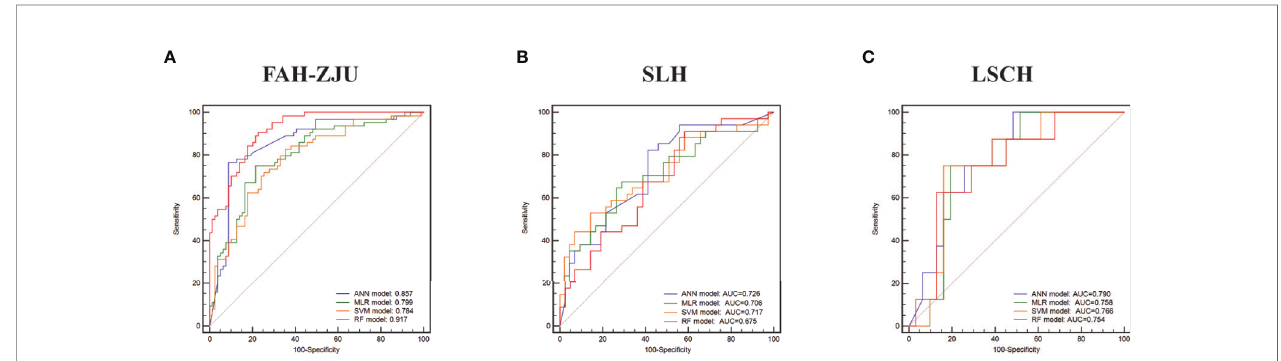
FIGURE 4 | The comparison of diagnostic performance of arti fi cial neural network (ANN), multiple logistic regression (MLR), random forest (RF), and support vector machine (SVM) classi fi ers in the training cohort [ (A) First Af fi liated Hospital of Zhejiang University School of Medicine (FAH-ZJU)] and validation cohorts [ (B) Shulan Health (Hangzhou) Hospital (SLH); (C) Lishui Central Hospital (LSCH)]. The performance was measured by the area under the receiver operating characteristic (AUROC) curve. ANN classi fi er (purple line), MLR classi fi er (green line), RF classi fi er (red line), SVM classi fi er (orange line).